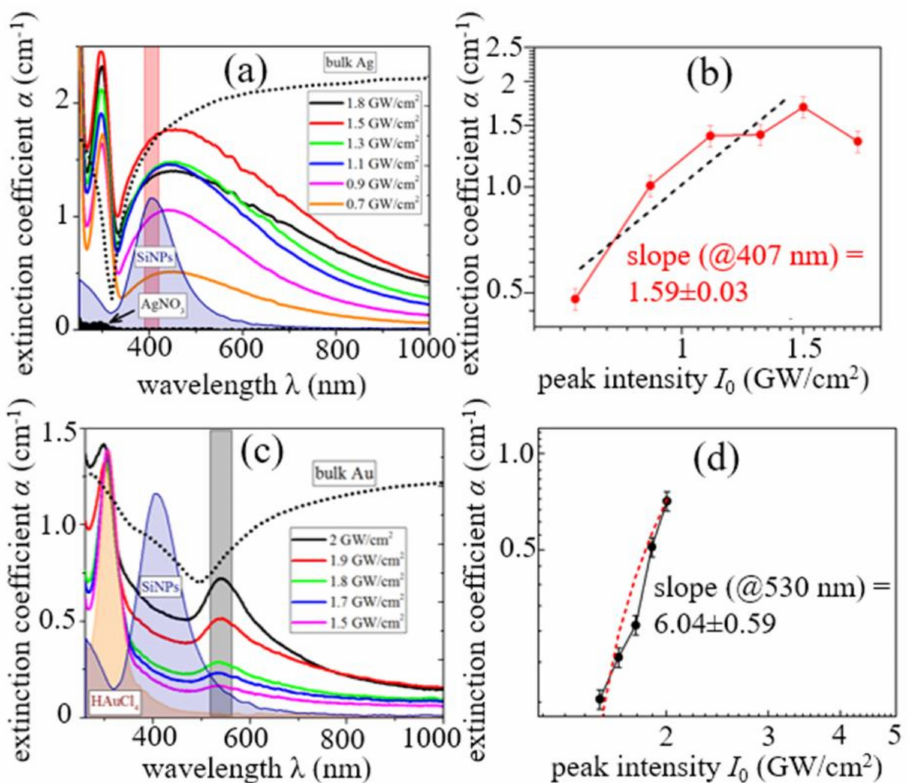
Figure 12. Spectra of extinction coefficients for Si@Ag ( a ) and Si@Au ( c ) colloids fabricated at different laser intensities I 0 ; ( b , d ): The corresponding dependences of the extinction coefficient at 407 nm and 530 nm, respectively (LSPR peak position) on I 0 (data presented as log–log plots) with linear approximations.